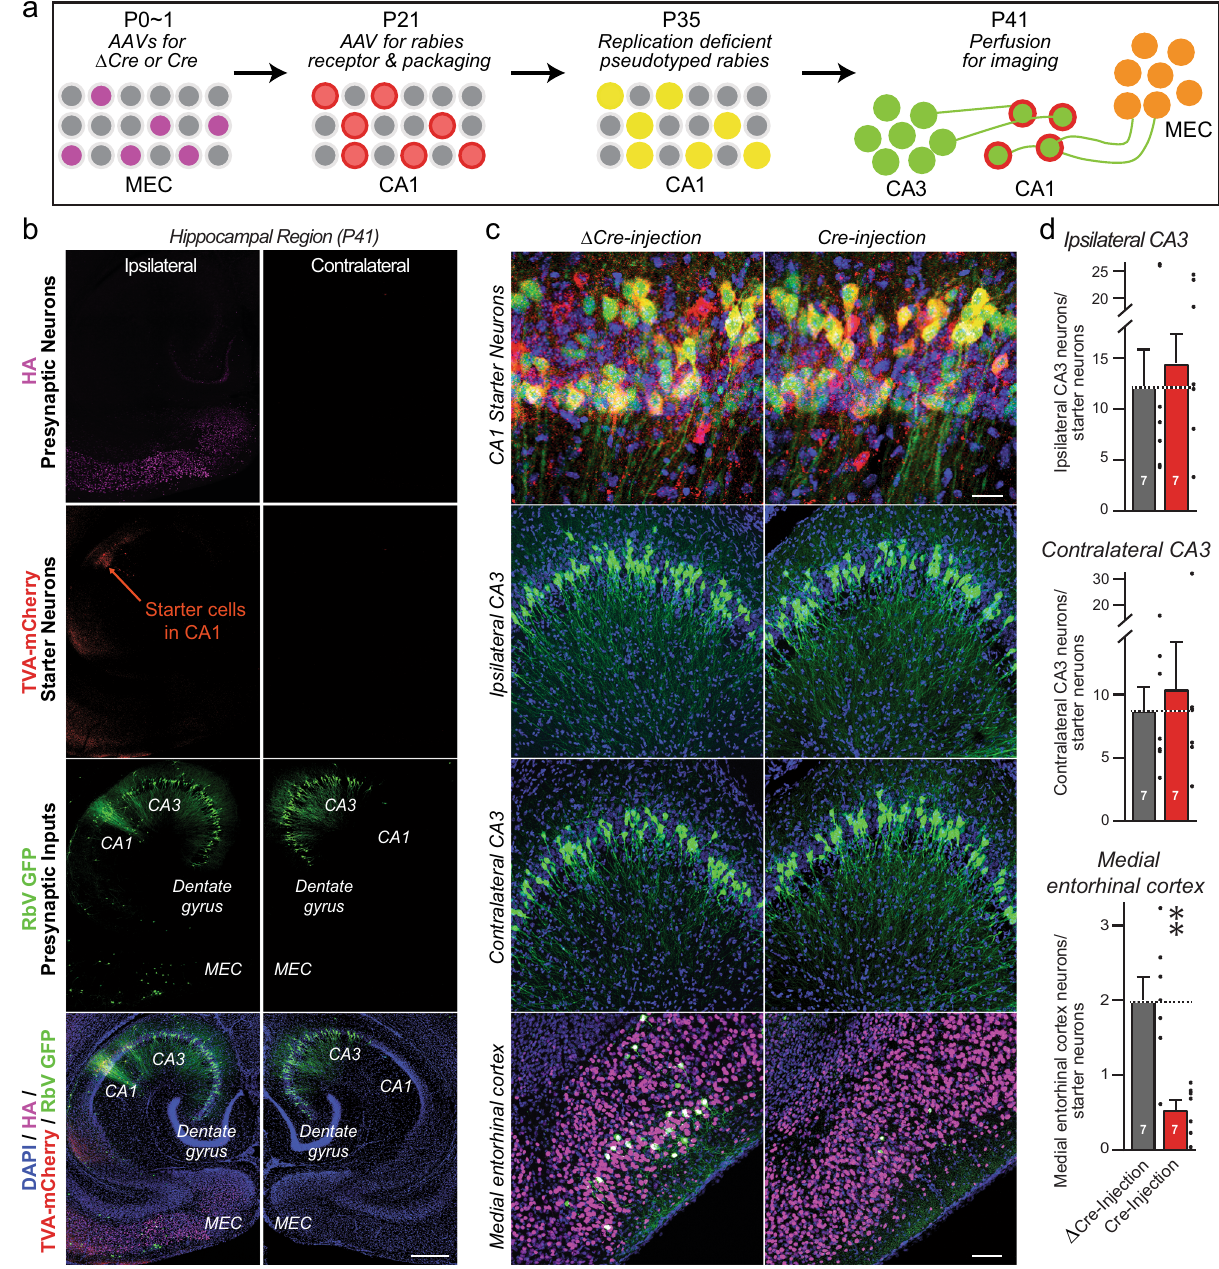
Fig. 9 Pseudorabies tracing demonstrates that the presynaptic deletion of Tenm3 and Tenm4 in MEC neurons greatly decreases MEC → CA1 synaptic connectivity. a Experimental strategy that enables testing the effect of presynaptic Cre-mediated gene deletions on synaptic connections using retrograde pseudorabies virus tracing methods. MEC neurons of Tenm3/4 DcKO mice were infected unilaterally with AAVs encoding HA-tagged Δ Cre (control) or Cre at P0, proximal CA1 neurons were infected with AAVs encoding the Cre-independent mCherry-tagged rabies receptor and pseudorabies virus packaging proteins at P21. The same proximal CA1 neurons were infected with pseudorabies viruses encoding eGFP at P35, and the presynaptic inputs from the ipsi- and contralateral hippocampal CA3 region and the ipsilateral MEC were analyzed by imaging at P41. b Representative images of a pseudorabies virus retrograde tracing experiment analyzing the effect of a presynaptic Tenm3/4 deletion on synaptic inputs onto CA1 neurons (top, HA (magenta) signal in the MEC from Δ Cre and Cre; second row, mCherry (red) signal in the CA1 from the pseudorabies virus receptor (starter cells); third row, eGFP (green) signal visualizing presynaptic inputs onto CA1 neurons; bottom row, merged images including a nuclear DAPI (blue) stain). c Representative higher resolution images of retrograde trans-synaptic tracing experiments in control mice ( Δ Cre, left images) and mice with a presynaptic deletion of Tenm3/4 in the MEC (right images). Images show starter neurons (top), ipsi- and contralateral presynaptic CA3 region input neurons (middle rows), and ipsilateral MEC input neurons (bottom). d Quanti fi cations of presynaptic inputs onto postsynaptic proximal CA1 neurons as a function of the presynaptic Tenm3/4 deletion in the MEC show that presynaptic Tenm3 and Tenm4 in MEC are required for normal synaptic connections formed by MEC neurons onto CA1 neurons. Note that presynaptic Tenm3/4 deletions in the MEC do not affect synaptic connections formed by CA3 neurons onto CA1 neurons because the CA3 neurons were not manipulated genetically. Data are means ± SEM; numbers of mice are indicated in the bars. Statistical signi fi cance was assessed using two-sided Student ’ s t-test (** p < 0.01). Scale bars: 0.5 mm ( b ), 20 µ m ( c , top panel) and 100 µ m ( c , bottom three